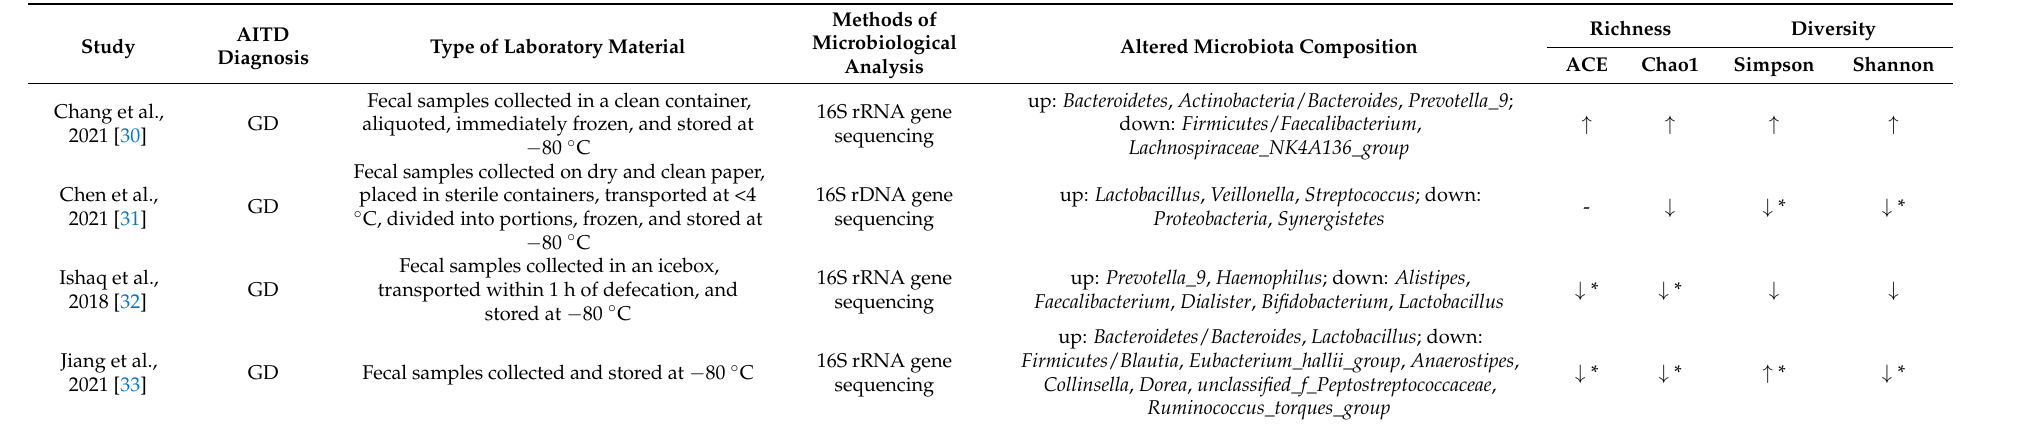
Table 2. Detailed characteristics of the included studies considering microbiological analysis and microbiota